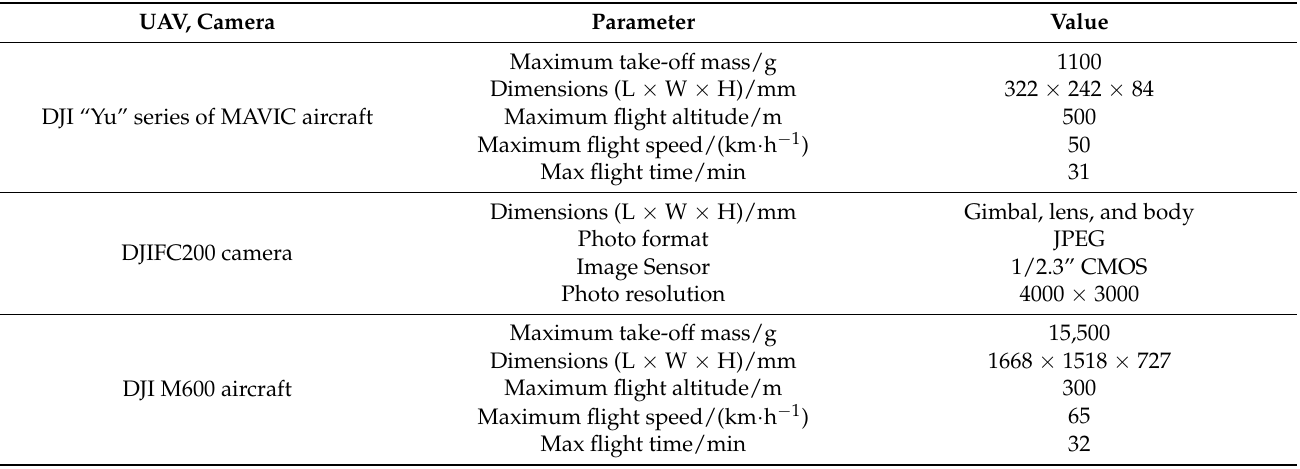
Figure 3. DJI M600 aircraft. Table 1. UAV and airborne camera parameters.